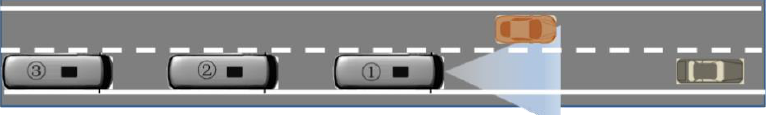
Figure 2. Train serial number setting (𝑖) , ①②③ where denotes the i-th vehicle, i.e., the first, the second, and the third.